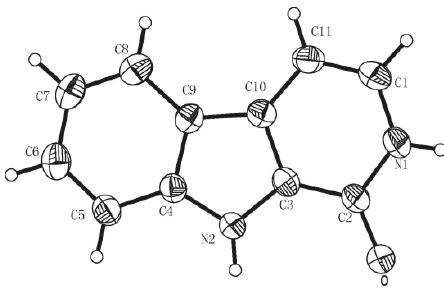
Figure 2. ORTEP drawing of the X-ray crystal structure of compound 4-2. Displacement ellipsoids were drawn at 50% probability level.